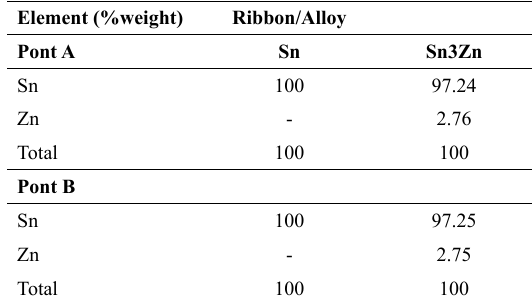
Figure 1. Micrographs obtained by Scanning Electron Microscopy and EDS spectra obtained at the points A and B: (a) Surface of Sn-ribbon, face of contact with the metal wheel on cooling; (b) Surface of Sn-ribbon, face without contact with the metal wheel on cooling; (c) Surface of Sn3Zn-ribbon, face of contact with the metal wheel on cooling; (d) Surface of Sn3Zn-ribbon, face without contact with the metal wheel on cooling. Table 1. Microanalysis of Sn and Sn3Zn- ribbons obtained by